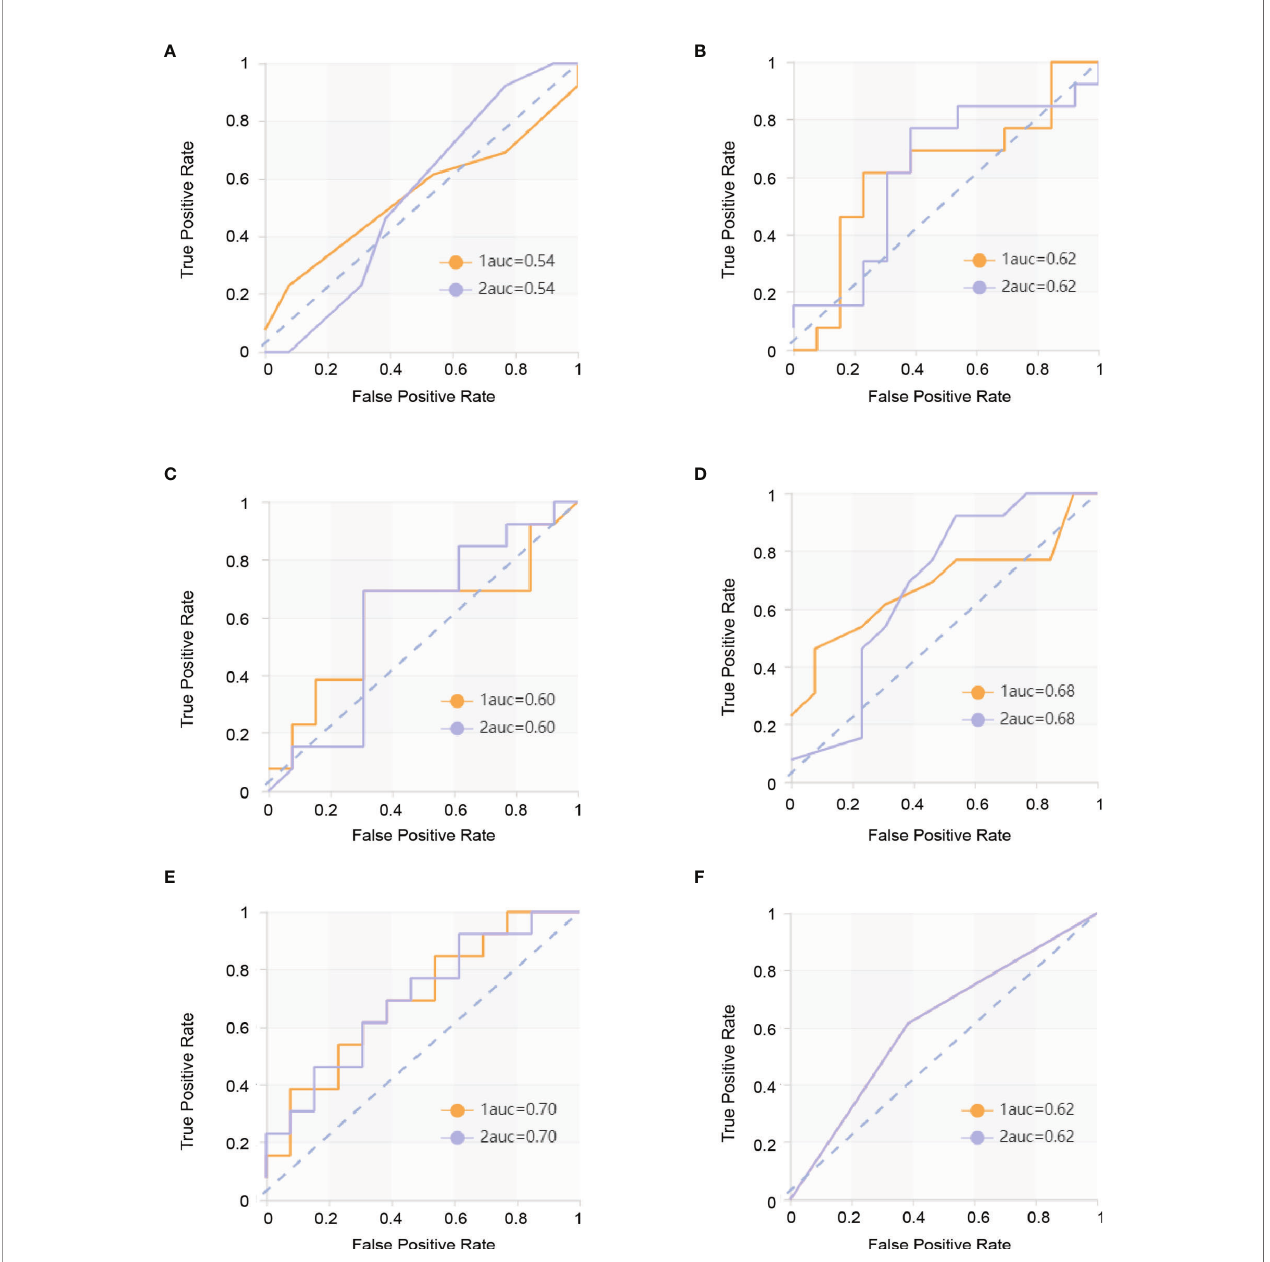
FIGURE 2 | ROC curves in arterial phase. The yellow curve is the poor prognosis group (PP group), and the blue curve is the good prognosis group (GP group). (A) ROC curve of the KNN model in the validation set. The AUC were 0.544 in the PP group (sensitivity and speci fi city were 0.46 and 0.62, respectively) and 0.544 in the GP group (sensitivity and speci fi city were 0.46 and 0.62, respectively). (B) ROC curve of the SVM model in the validation set. The AUC were 0.621 in the PP group (sensitivity and speci fi city were 0.62 and 0.69, respectively) and 0.621 in the GP group (sensitivity and speci fi city were 0.69 and 0.62, respectively). (C) ROC curve of the XGBoost model in the validation set. The AUC were 0.601 in the PP group (sensitivity and speci fi city were 0.69 and 0.38, respectively) and 0.601 in the GP group (sensitivity and speci fi city were 0.38 and 0.69, respectively). (D) ROC curve of RF model in the validation set. The AUC were 0.680 in the PP group (sensitivity and speci fi city were 0.62 and 0.69, respectively) and 0.680 in the GP group (sensitivity and speci fi city were 0.69 and 0.62, respectively). (E) ROC curve of the LR model in the validation set. The AUC were 0.698 in the PP group (sensitivity and speci fi city were 0.62 and 0.62, respectively) and 0.698 in the GP group (sensitivity and speci fi city were 0.62 and 0.62, respectively). (F) ROC curve of the DT model in the validation set and ROC curve of the validation set. The AUC were 0.615 in the PP group (sensitivity and speci fi city were 0.62 and 0.62, respectively) and 0.615 in the GP group (sensitivity and speci fi city were 0.62 and 0.62,